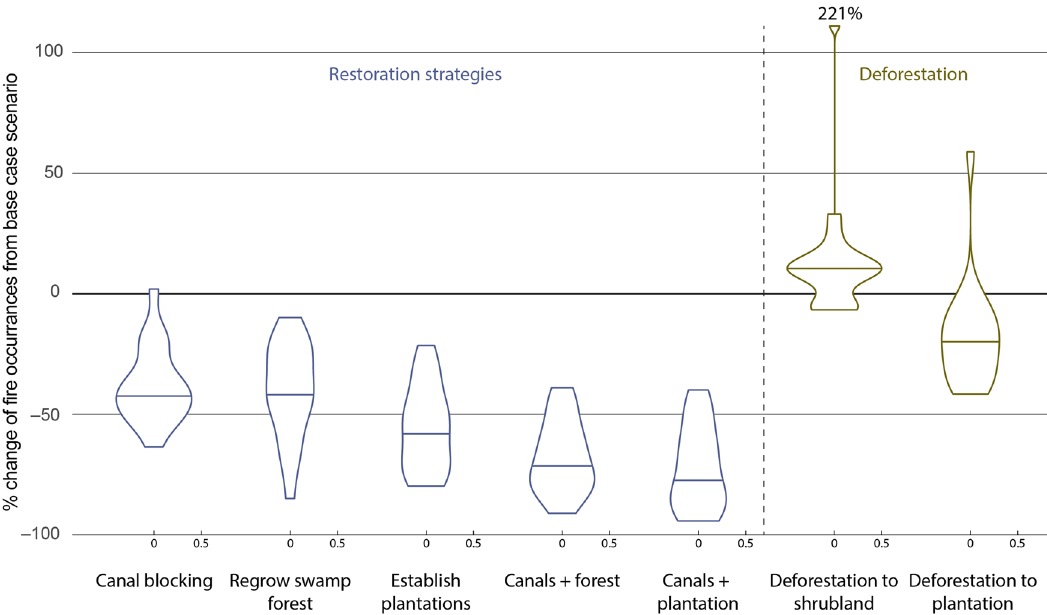
Fig. 4 Land management scenario results. Percentage change from base case scenario yearly modelled fi re-occurrences (2002 – 2019) for each management scenario displayed as violin plots showing the entire distribution of values about the median (black line) with one outlier falling beyond the y - axis as marked. The x -axis values are the proportion of the total number of observations within each group (0 – 1). The data used to generate Fig. 4 can be found in Supplementary Data